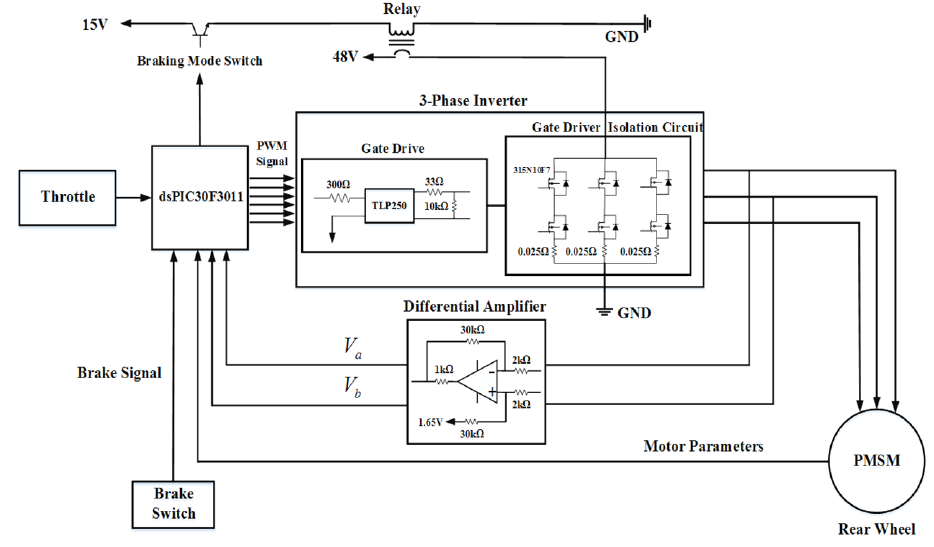
Figure 9. Hardware Figure 9. Hardware architecture.